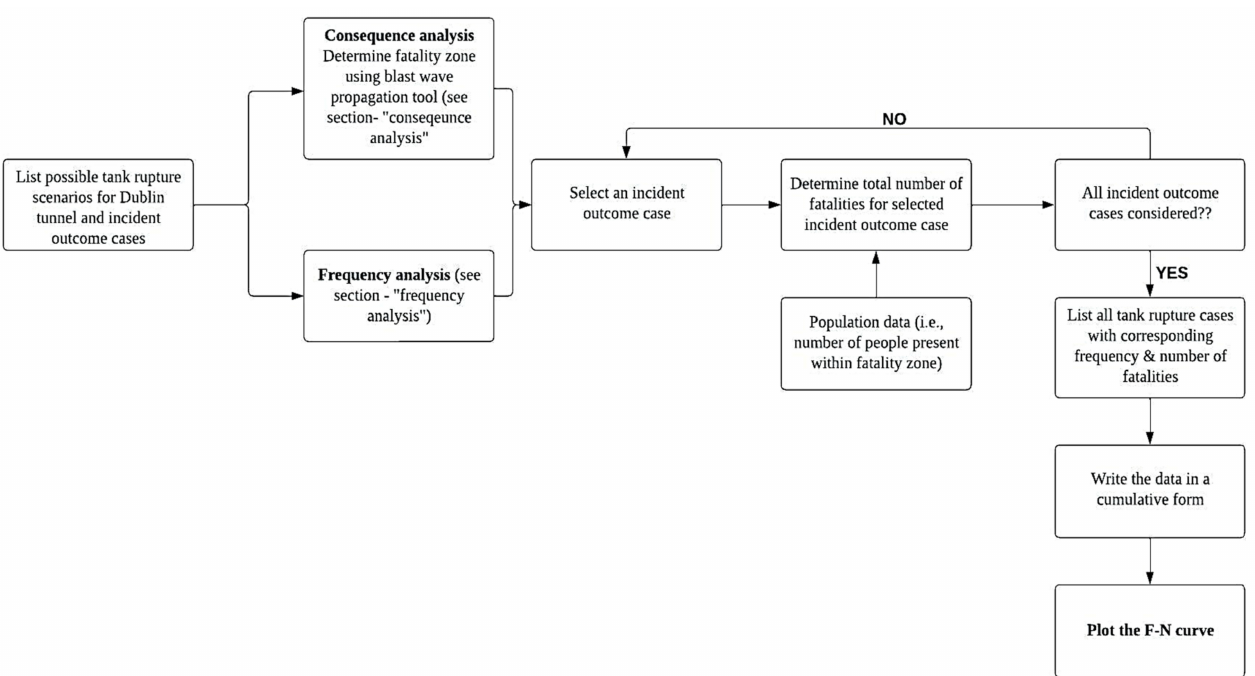
Figure 6. Procedure for the calculation of societal risk: F–N